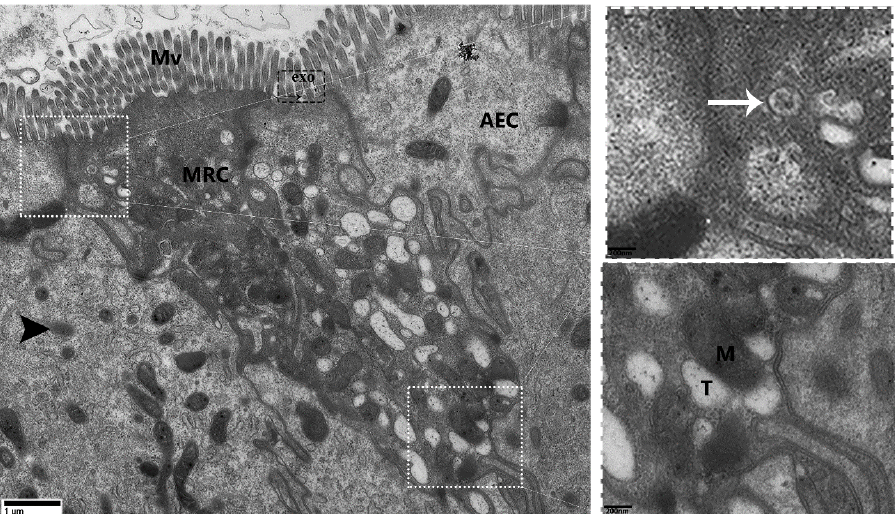
Figure 3. Transmission electron micrograph of an MRC that exhibits exosome secretion in the mucosal layer of P. sinensis . Mitochondria-rich cells (MRCs), absorptive epithelial cell (AEC), mitochondria (M), tubular system (T), multivesicular bodies (white arrow), exosome (exo), lysosome (black arrowhead), and microvilli (Mv). Scale bar = 1 µ